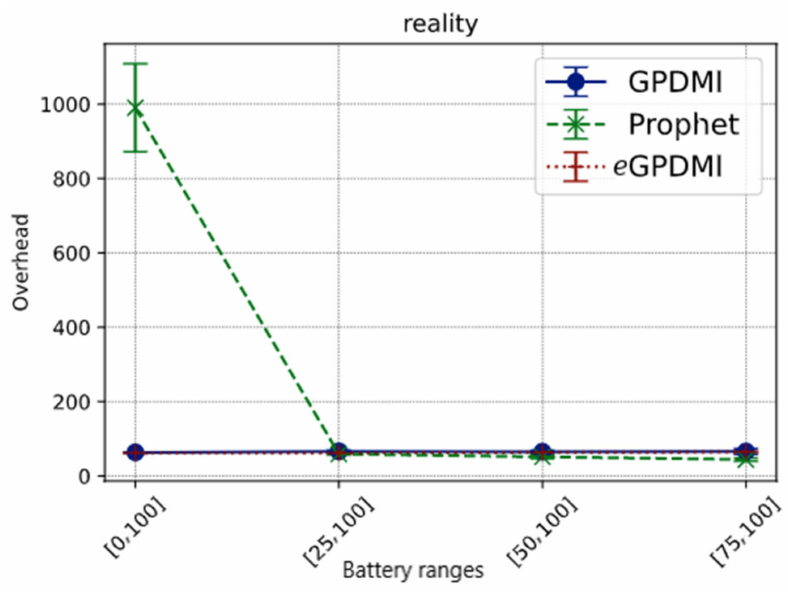
Figure 8. Network overhead vs. battery ranges in Reality scenario.